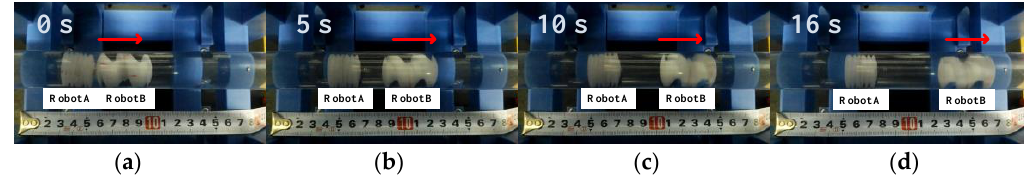
Figure 12. The video snapshots of release procedure: ( a ) two robots dock together; ( b ) Robot B releases from Robot A; ( c ) Robot B moves away from Robot A; and ( d ) Robot B is far away from Robot A.